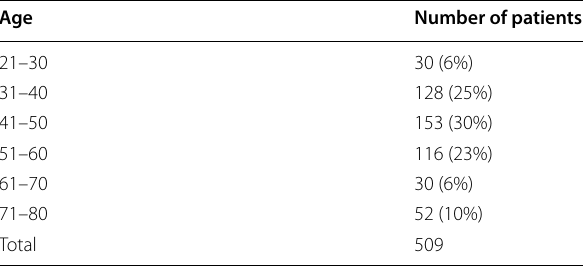
Table 1 Distribution of patients according to their age